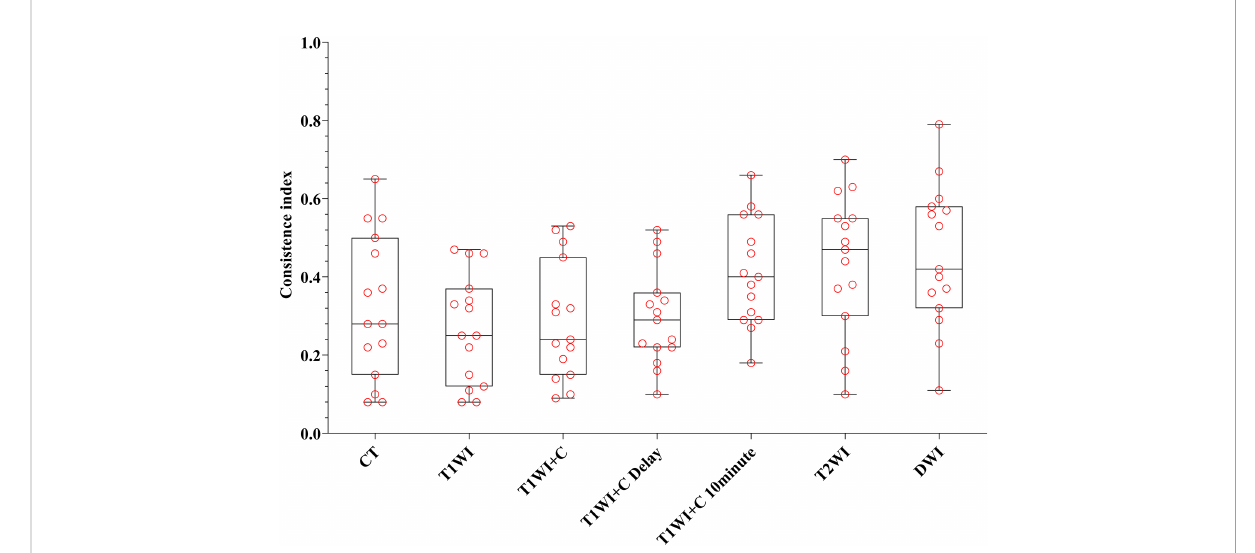
FIGURE 3 The boxplot of CI. The black line of the box is the median, and the length of the box represents the interquartile range.